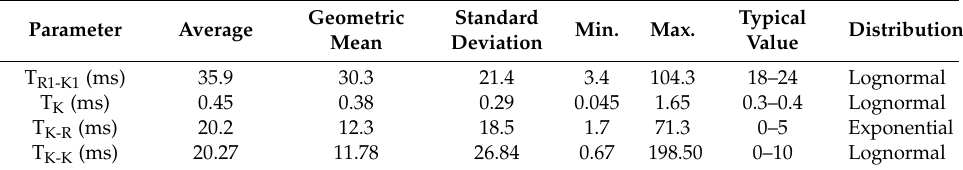
Figure 5. Histograms of the measured parameters of consecutive K-changes: ( a ) T RS1-K1 , ( b ) T K , ( c ) T K-RS , and ( d ) T K-K . Histograms ( a , b , d ) Follow Lognormal distribution while ( c ) follows an Exponential distribution. The dotted red lines indicate the assigned distributions. Table 3. Summary of the statistics of the distributions in Figure